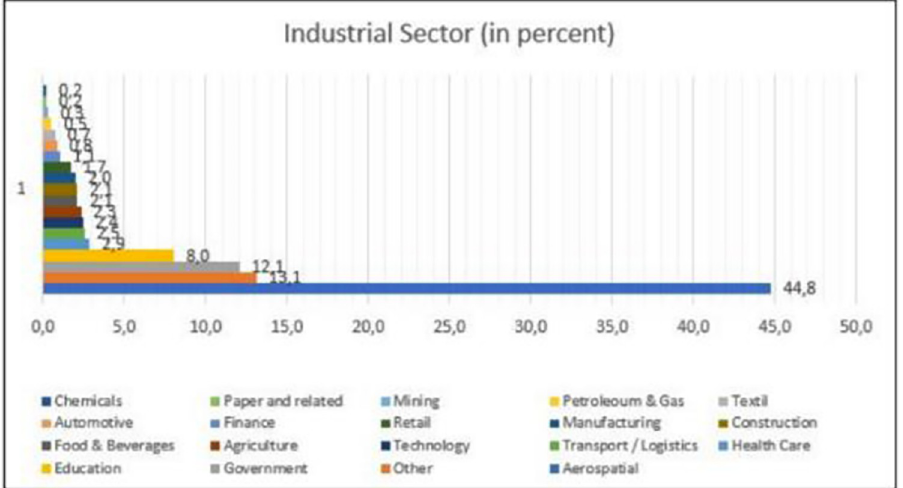
Fig 2. Industrial sector of the respo 1. Source: By the authors